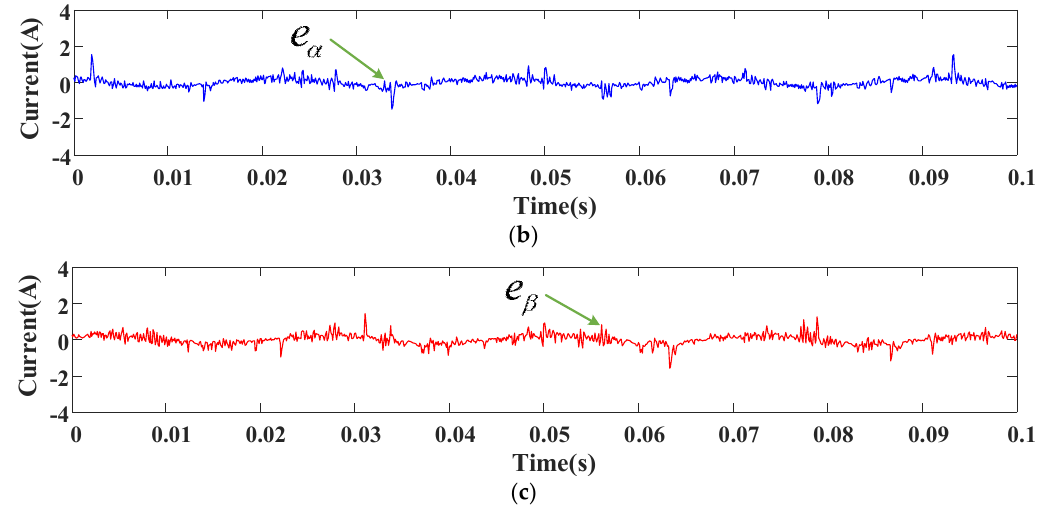
Figure 23. Experimental results of DVV-MFPCC under speed 1300 rpm and load 1 Nm (case 4): ( a ) current responses; ( b ) α -axis current error; ( c ) β -axis current error.